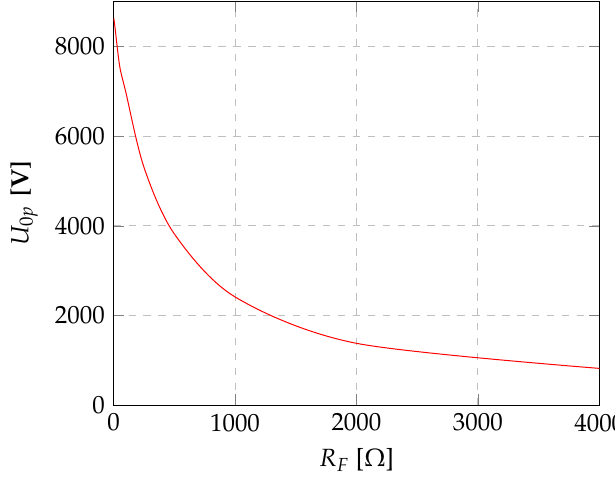
Figure 7. RMS values of zero-sequence voltage in the network with the neutral point grounded by the resistor and in the compensated network as a function of the R F transition resistance.